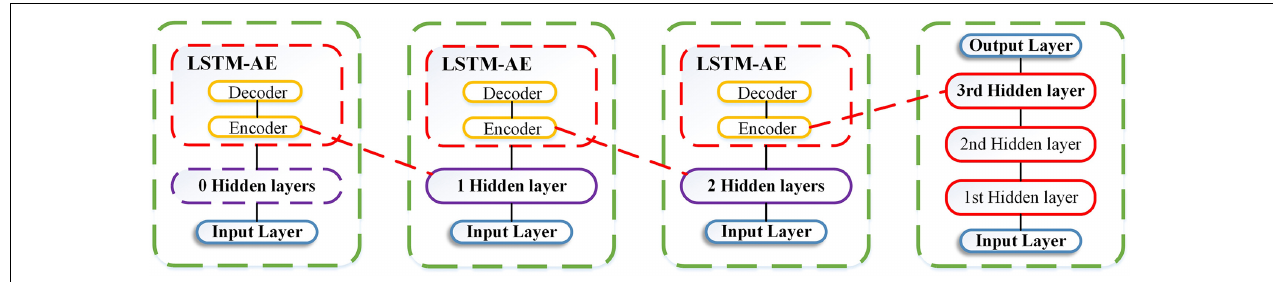
FIGURE 2 | LSTM-SAE model.